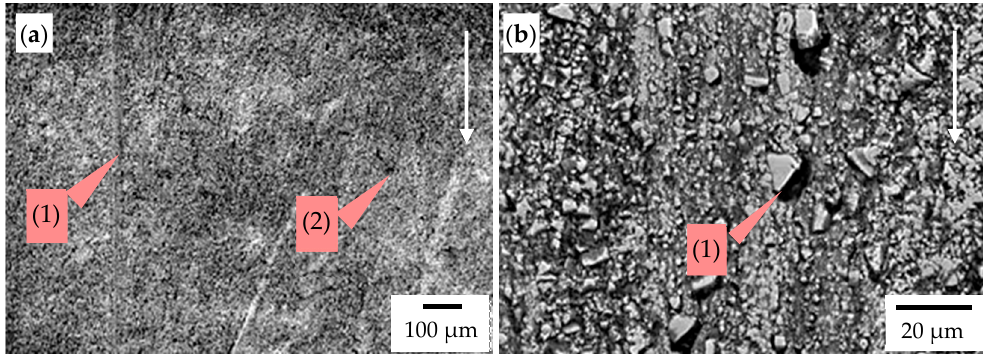
Figure 15 . The worn surface of the cemented-carbide plate operating in the soil: chisel B, zone Z3 indicated in Figure 5; the white arrow presents the direction of the impact of soil. ( a ) Visible traces of the interaction of soil particles in the cobalt matrix (grinding effect) (1) and pits (2) and ( b ) visible WC grains poorly embedded in the cobalt matrix (1), which was removed. SEM, SE detector.